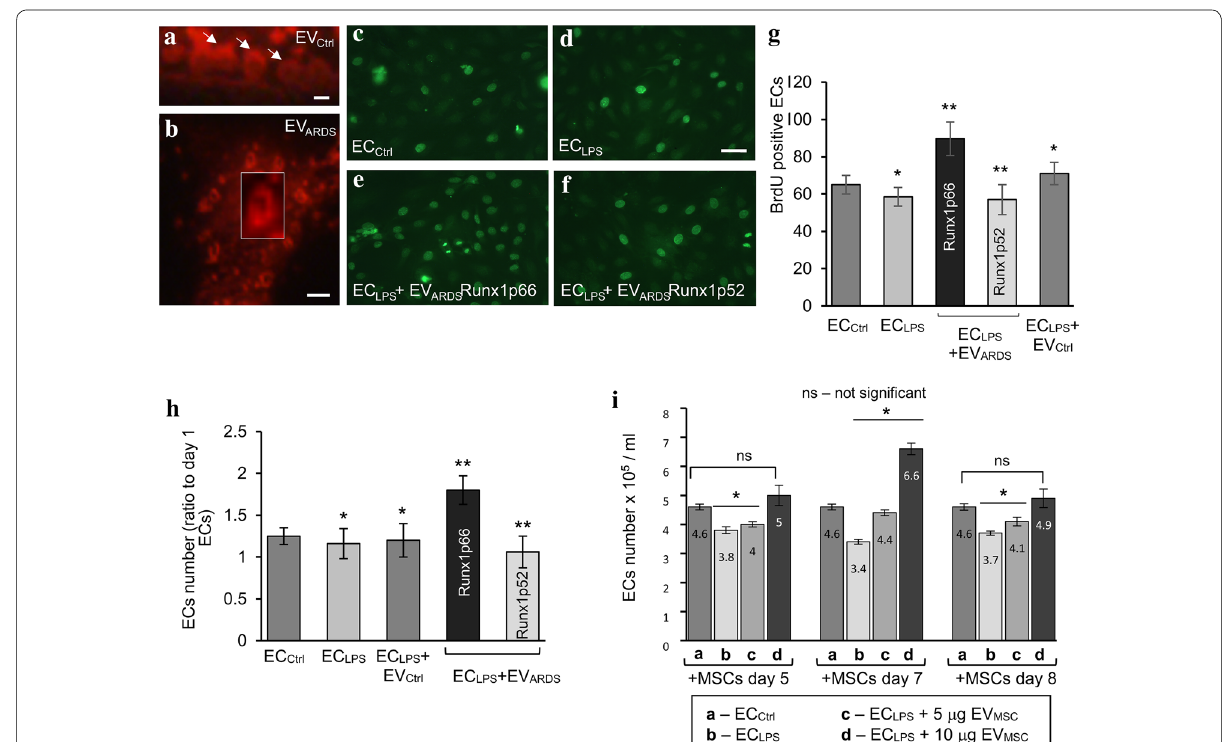
Fig. 5 EV ARDS Alk5Runx1p66 increase proliferation of LPS-treated ECs. Biotin/neutrAvidin-Alexa Fluor 594 labeling of EVs isolated from a human healthy donor ( a , EV Ctrl ) and an ARDS subject ( b , inset; EV ARDS ). Arrows in a indicate several donut-shaped EV Ctrl . Bars: 1 μm ( a , and b inset), 2 μm ( b ). n 3. BrdU labeling of EC Ctrl ( c ), EC LPS ( d ) and EC LPS exposed to EV ARDS Alk5Runx1p66 isolated from the blood of a long-term ARDS survivor ( e ) and = EC LPS exposed to EV ARDS Alk5Runx1p52 isolated from the blood of a non-surviving ARDS patient ( f ). A dose of 1.6 was used for the micrographs shown. Bars: 50 μm ( c – f ). g Quantification of BrdU-positive cells. The results are expressed as BrdU-positive ECs/high power field (50 power field images/experimental condition). Data are representative of three different experiments and were normalized per total number of cells counted. Values are shown as